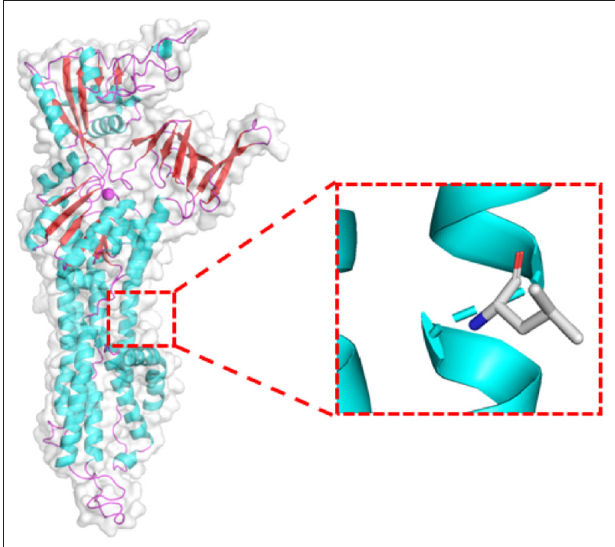
FIGURE 3 | Prediction of the protein structure of the ATP7B(R778L) mutant expression